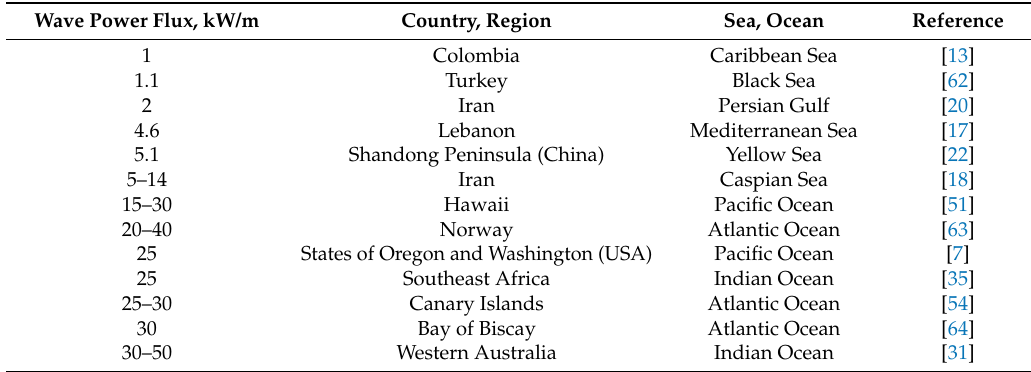
Table 1. The distribution of wave energy resources